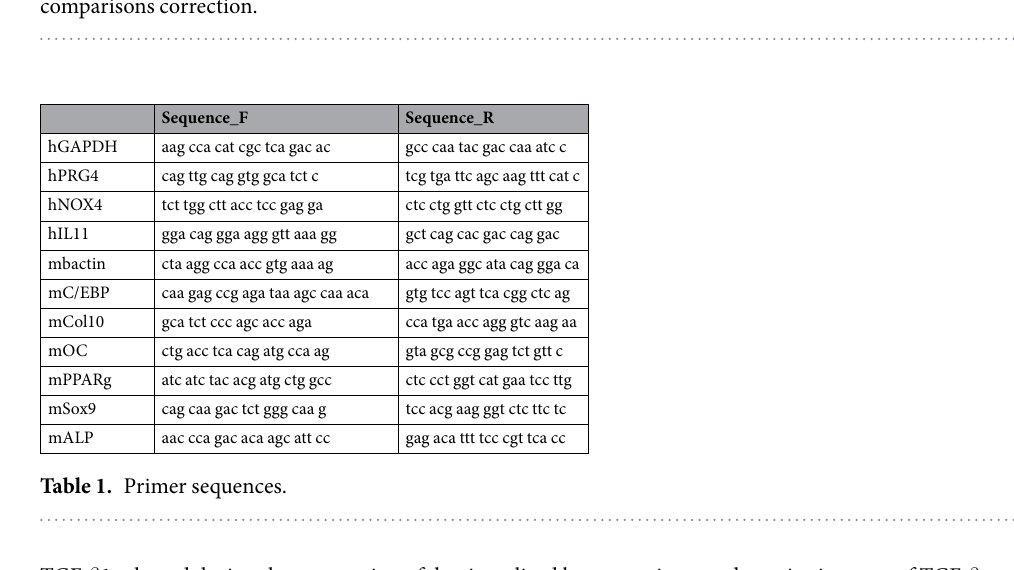
Figure 3. Viability of primary oral fibroblast exposed to acid bone lysate (ABL). Cell viability staining of primary oral fibroblast upon exposure to ABL was tested by MTT assay ( a ) and Live-Dead staining ( b ). The results from these experiments demonstrated that stimulation with ABL at 5% is highly biocompatible with oral fibroblast. Live-Dead staining was done with viable cells appearing in green and dead cells in red. N = 3–5. Data represent the mean ± SD relative to the control. * P < 0.05, by Kruskal-Wallis test with Dunn’s multiple comparisons correction.